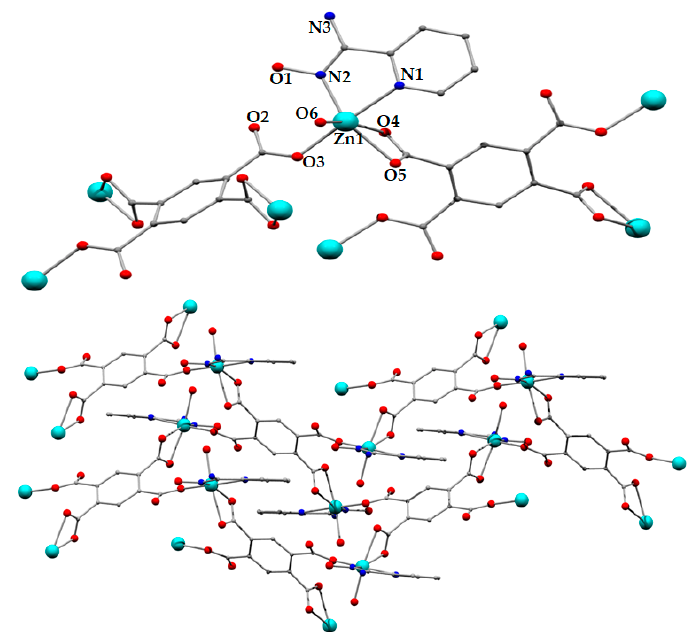
Figure 3. Representation of the repeating unit ( top ) and a part of the 2D chain of 3 ( bottom ). Color code: Zn 2+ , turquoise; N, navy blue; O, red; C, grey. The hydrogen atoms are omitted for clarity.